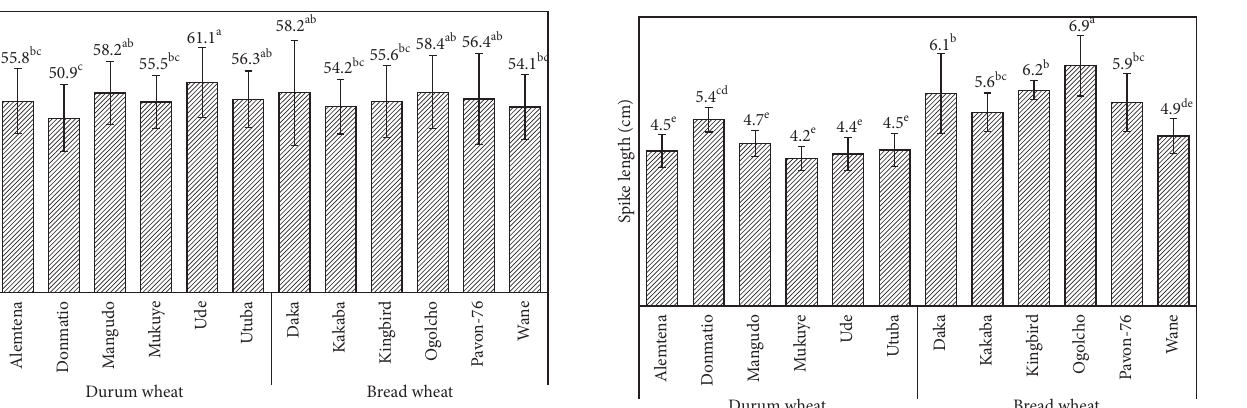
Figure 1: Means for the main effects of variety and water stress on the plant height of durum and bread wheat in Kulumsa.